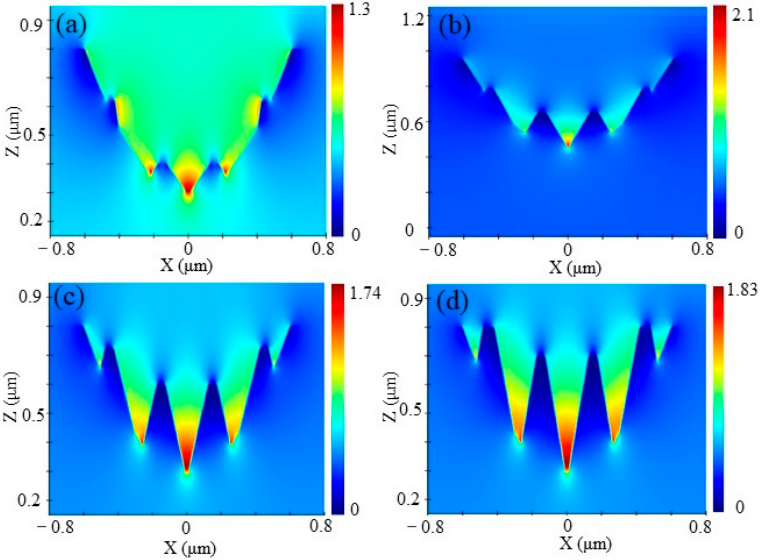
Figure 7. Simulated infrared transmittance ( a ) and reflectance ( b ) spectra of hybrid micro/nanostructure with different nanoripple heights.